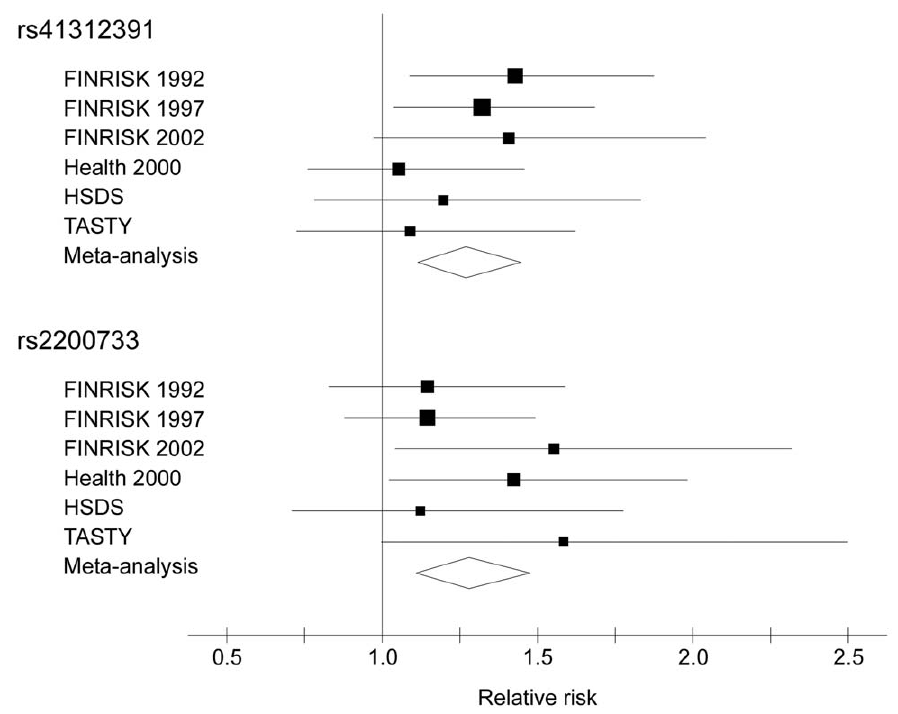
Figure 1. Forest plot of SCD risk ratios for rs41312391 and rs2200733. The figure shows point estimates for relative SCD risk (squares, area proportional to the inverse-variance weight) and 95% confidence intervals (horizontal lines) in all six cohorts, adjusting for sex and geographic region. The lateral tips of the diamonds indicate the 95% confidence intervals for the relative risk and the widest point of the diamond the relative risk estimate in the meta-analysis. HSDS = The Helsinki Sudden Death Study, SCD = sudden cardiac death, TASTY = The Tampere Autopsy Study.